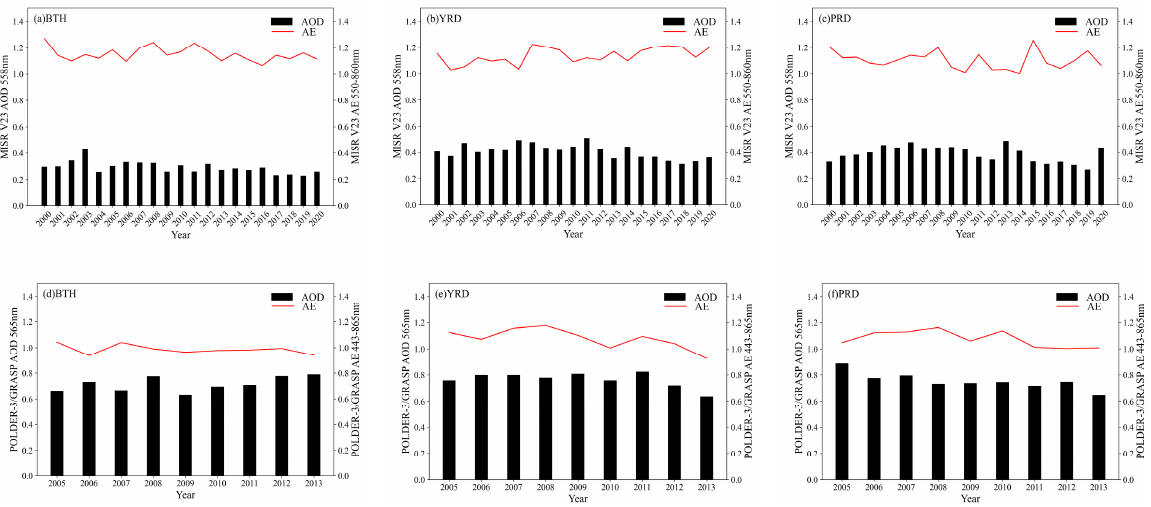
Figure 6. Variation figures of annual mean AOD and AE at BTH, YRD, and PRD. (MISR V23 products are present in the first panel ( a – c ); POLDER-3/GRASP products are present in the same order as in the second panel ( d – f ).